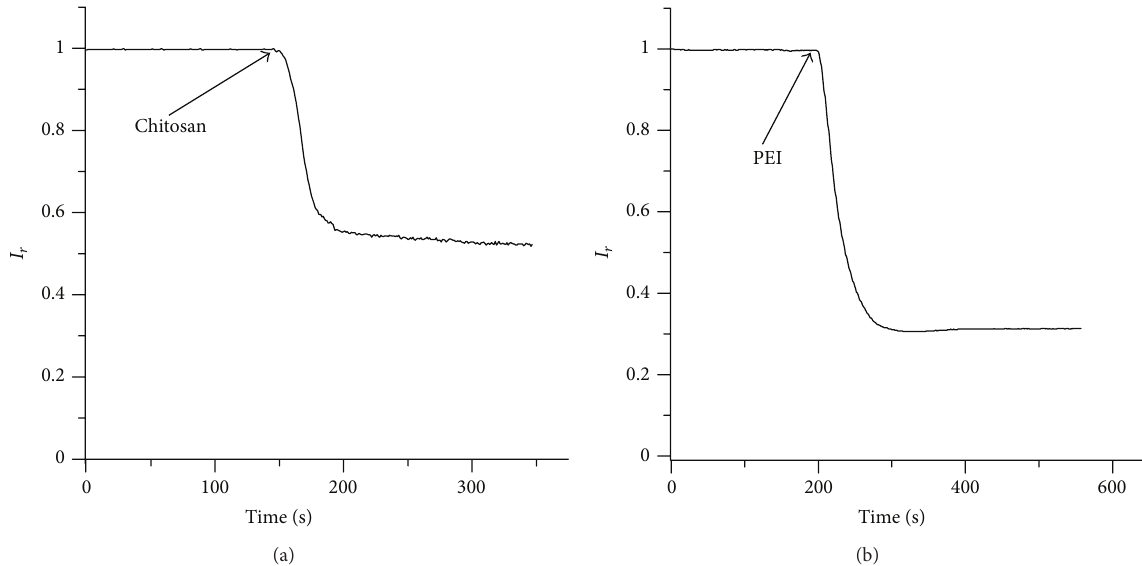
Figure 2: The evolution of the relative macroscopic current through a population of lysenin channels inserted into an Aso-based BLM in the presence of (a) 8 𝜇 M chitosan or (b) 4 𝜇 M PEI added to the cis chamber.